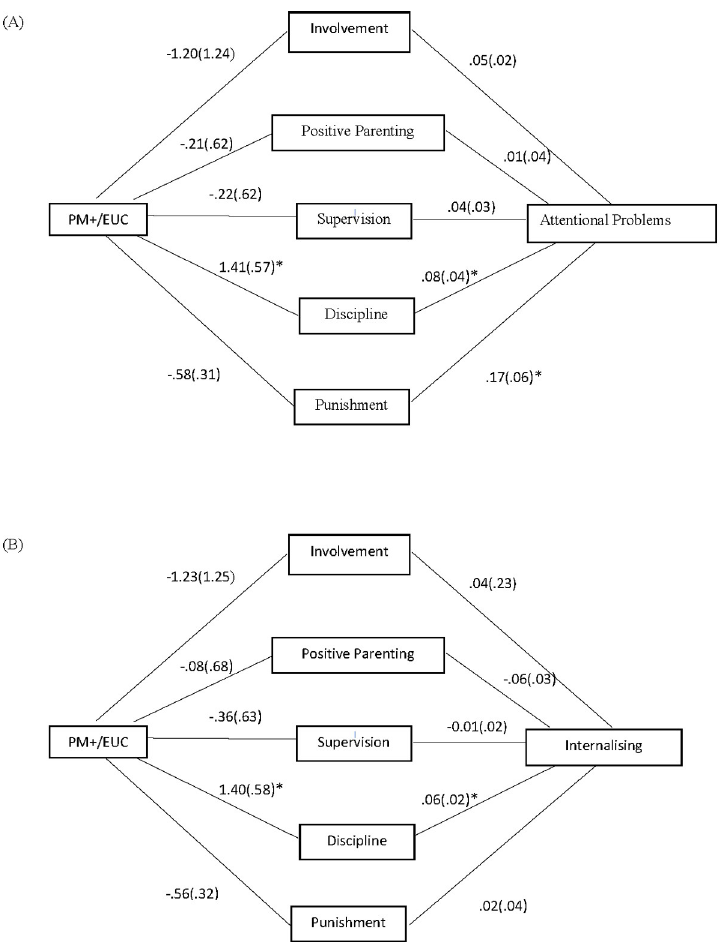
Fig 2. Path model of relationship between intervention, change in parenting style, and change in children’s mental health. Path model demonstrates that for refugees in gPM+, the more disciplinary parenting decreased (as measured by the APQ), there was a greater decrease in their children’s attentional (A) and internalizing (B) problems (as measured by the PSC). APQ, Alabama Parenting Questionnaire; EUC, enhanced usual care; gPM+, Group Problem Management Plus; PM+, Problem Management Plus; PSC, Pediatric Symptoms Checklist. Value are unstandardized coefficients (standard error). � Significant paths.